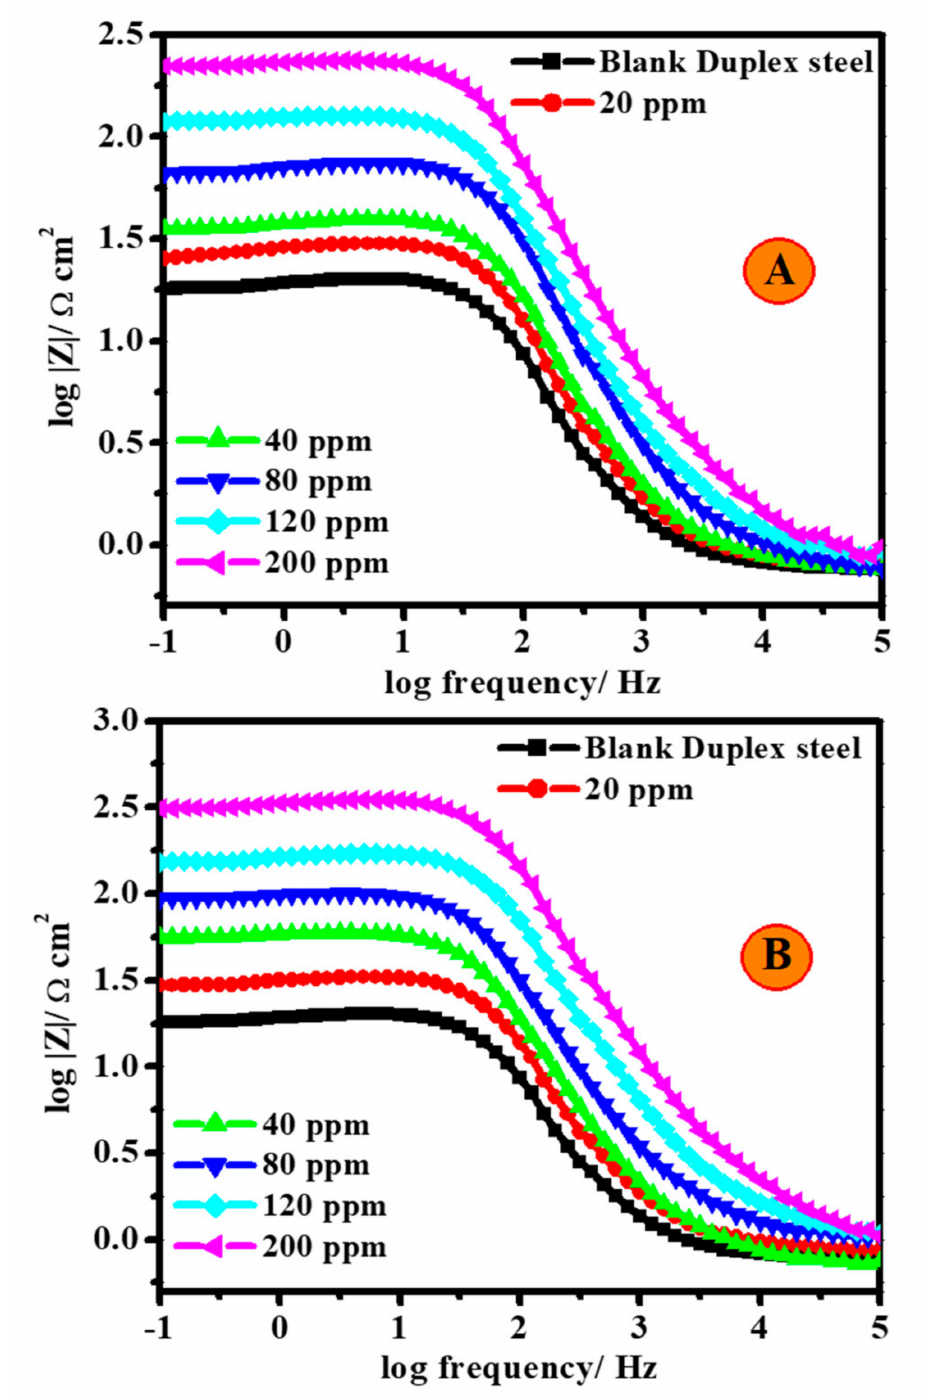
Figure 8. Bode profiles for duplex steel at 323 K in 2.0 M H 2 SO 4 with and without various concentra- tions of ( A ) CH and ( B ) CH/Zn@H 3